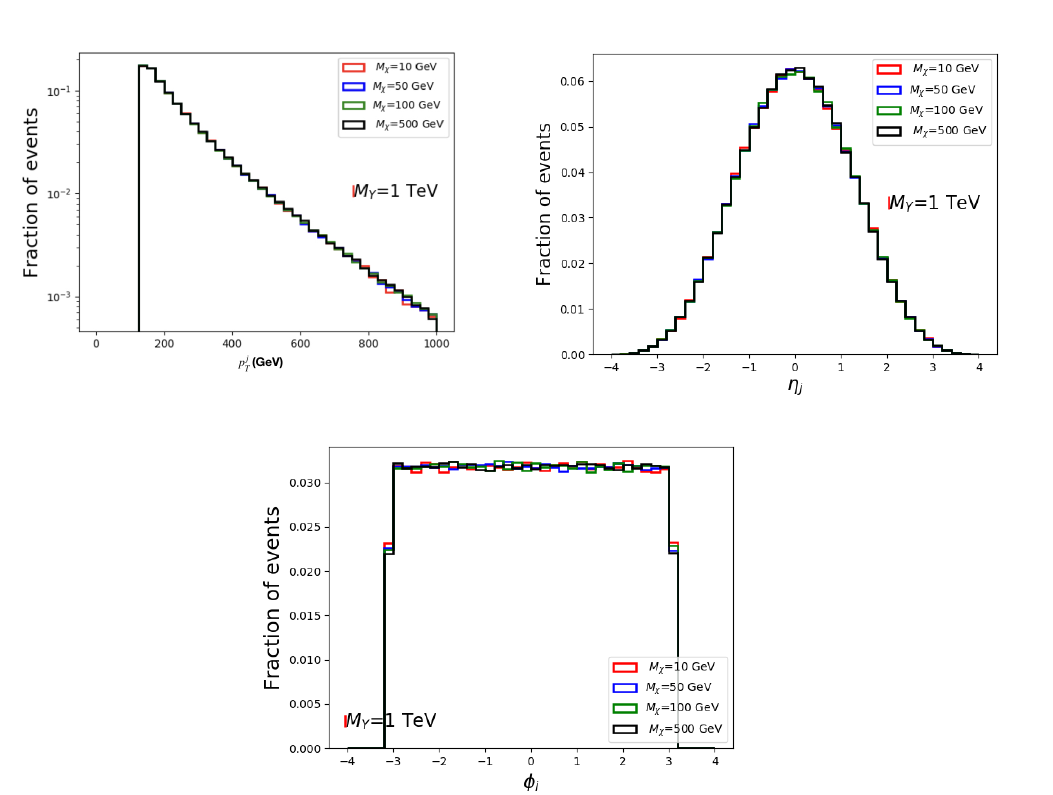
Figure A1: The p , η , and φ distributions for the monojet and MET process in case T of EFT spin-1 mediator (at parton-level) for fixed mediator mass and various dark matter